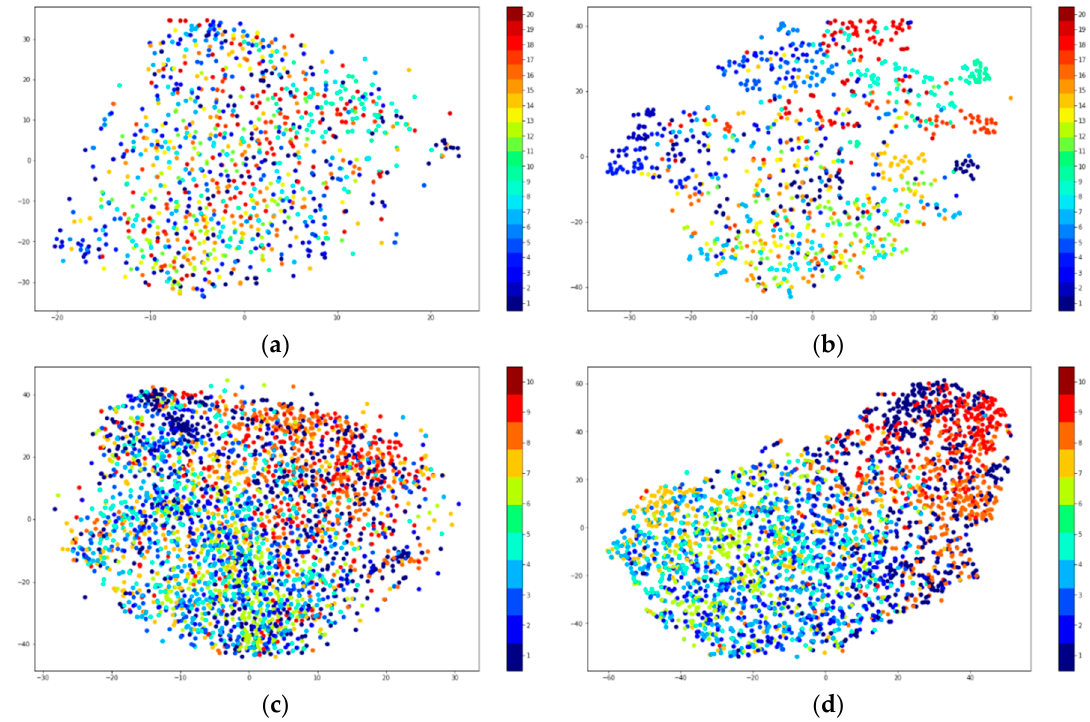
Figure 7. Visualization of raw pixel image and embedded visual vectors. ( a ) Seen class images in CIFAR-100 test dataset (N: 1000). ( b ) Seen class embedded vectors of CIFAR-100 test dataset (N: 1000). ( c ) Unseen class images in CIFAR-10 test dataset (N: 3000). ( d ) Unseen class embedded vectors of CIFAR-10 test dataset (N: 3000).